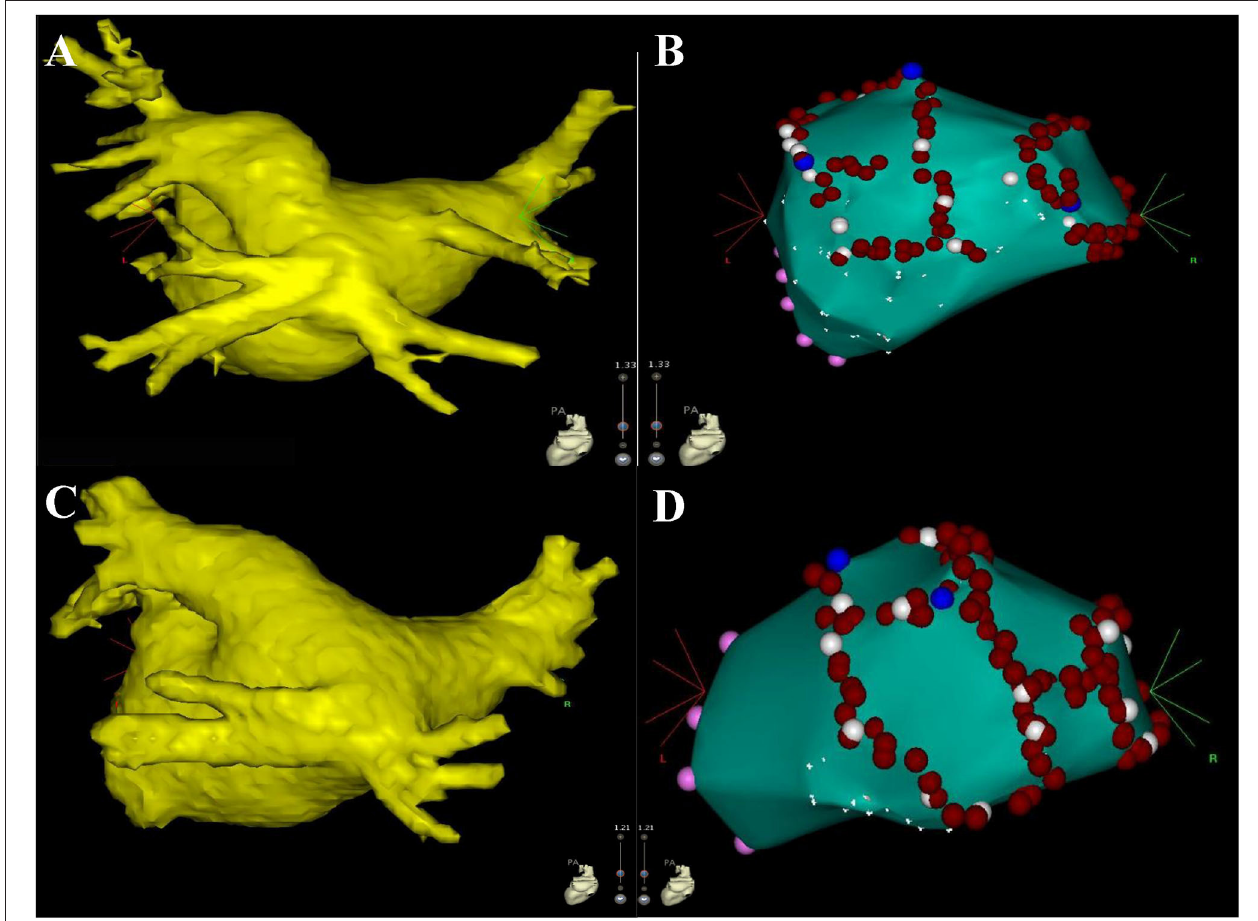
FIGURE 5 | The figures display the results of the redo procedure. The left atrium, mitral valve (pink dots), and pulmonary venous ostium (white dots) were firstly identified with point-by-point mapping, then the conduction gaps were ablated successfully (blue dots). Part of ostium was also ablated (red dots) for consolidating PVI. Three conduction gaps were identified for patient #1 in the CBA group (A,B) the anterior segment, the roof of LSPV, and the posterior segment of RSPV. Two conduction gaps were identified for patient #14 in the RFA group (C,D) the anterior segment of LSPV and the contiguous site between LSPV and the common ostium. CBA, cryoballoon ablation; LSPV, left superior pulmonary vein; RSPV, right superior pulmonary vein; PVI, pulmonary vein isolation; RFA, radiofrequency